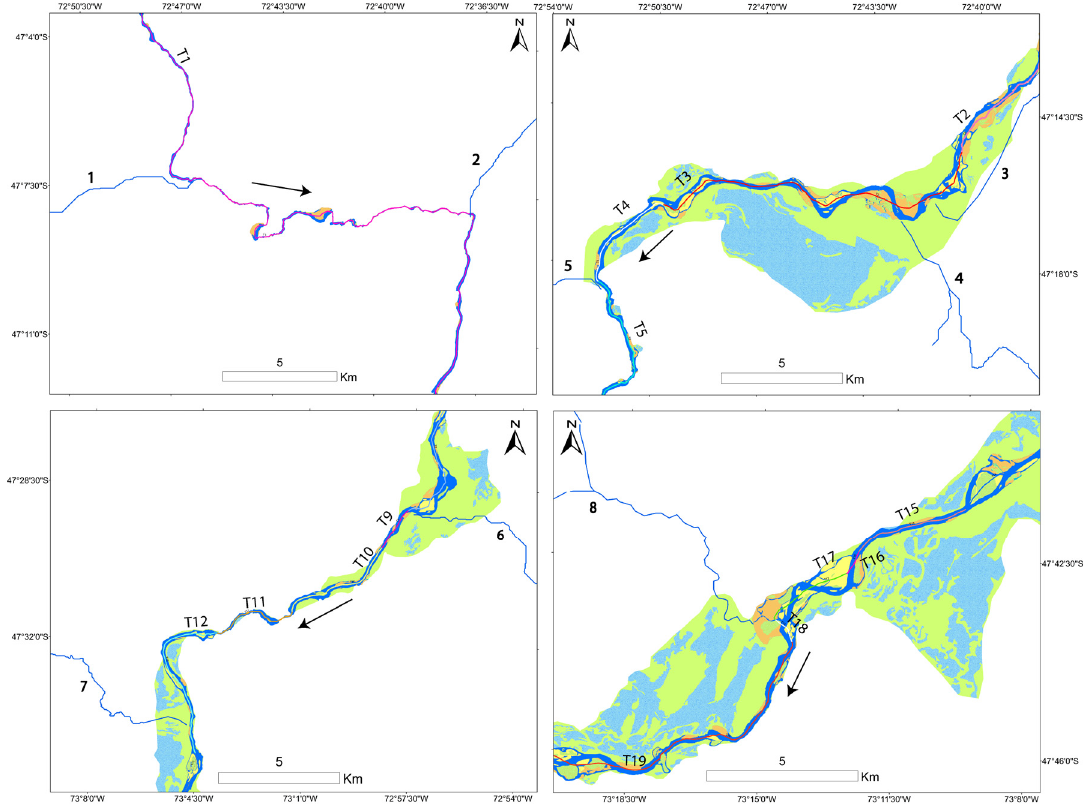
Figure 17. Baker case study: investigating the effect of tributaries.